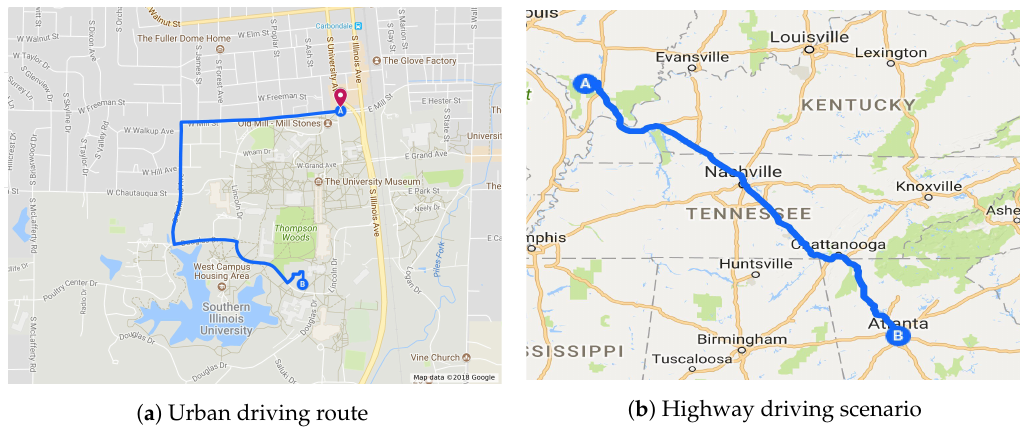
Figure 2. Route information in an urban and highway driving scenario.